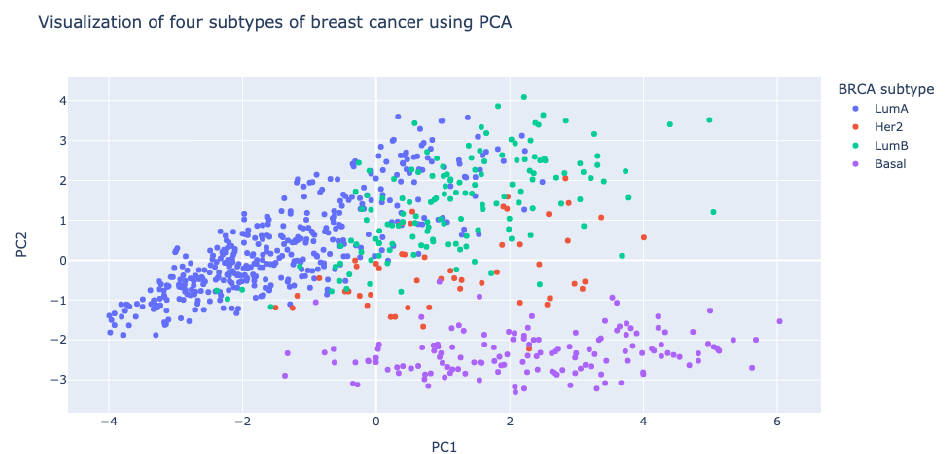
Figure 5. Visualization of four subtypes of breast cancer with respect to ∆ PCCs of gene pairs. Principal component analysis (PCA) was used for the visualization. ∆ PCCs of gene pairs in the basal-like subtype (violet dots) are very different from those in the other